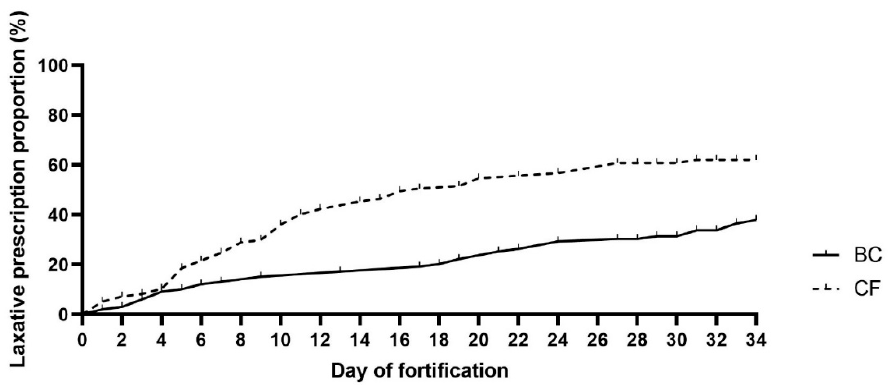
Figure 3. Time of initiation of prescribed laxatives. Bovine colostrum (BC) and Conventional fortifier (CF). Based on Survival analyses, using the Cox regression model.